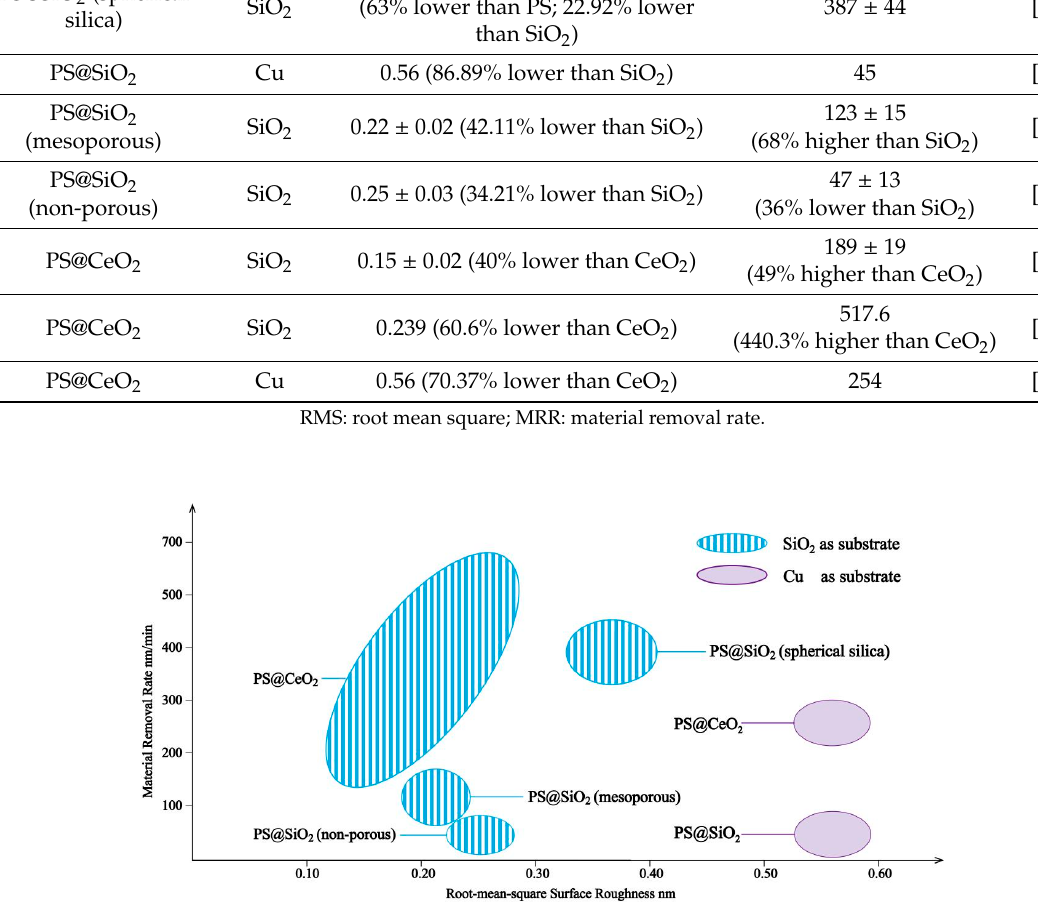
Table 4. Parameters of composite abrasives in chemical mechanical polishing.